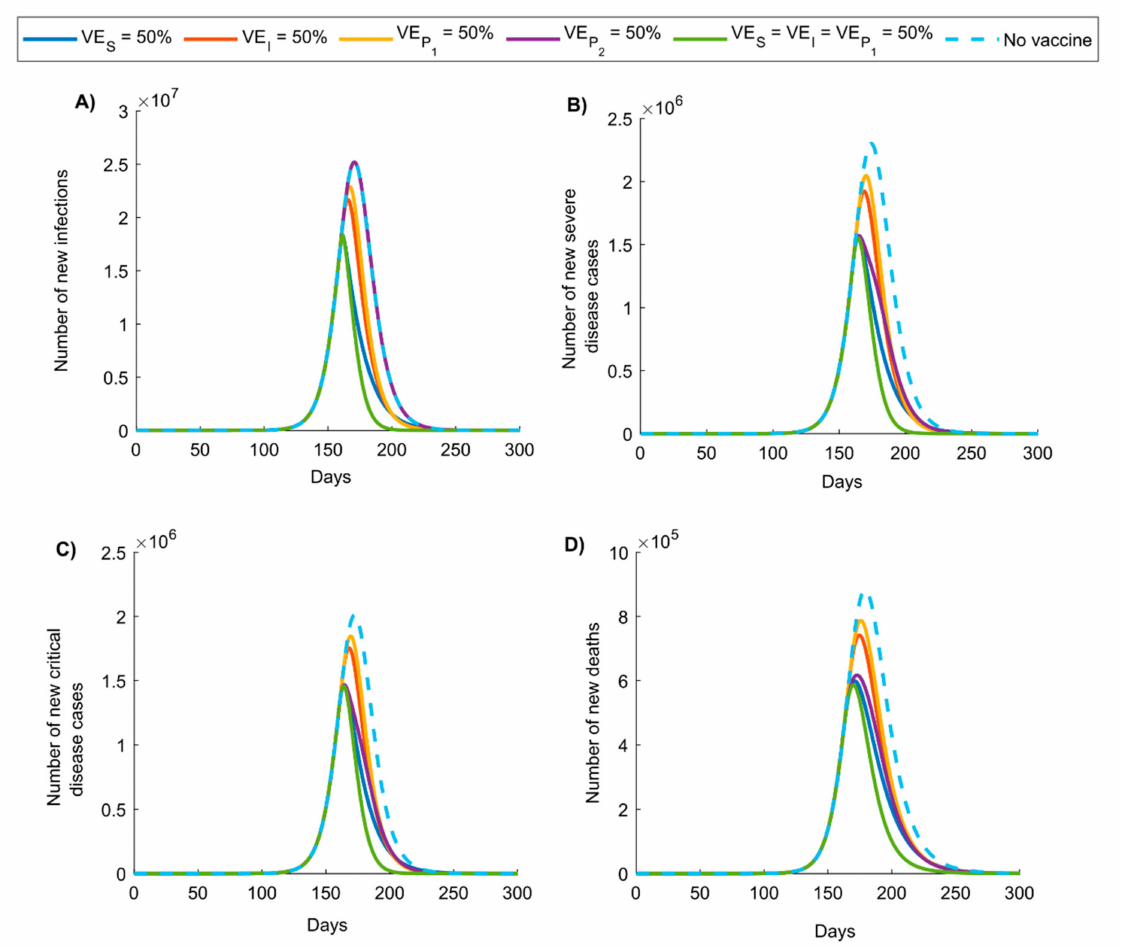
Figure 2. Impact of SARS-CoV-2 vaccination on the number of ( A ) new infections, ( B ) new severe disease cases, ( C ) new critical disease cases, and ( D ) new deaths in the scenario assuming vaccine introduction during the exponential growth phase of the epidemic, with scale-up to 80% coverage within one month. Duration of vaccine protection is 10 years. Impact was assessed at VE S =